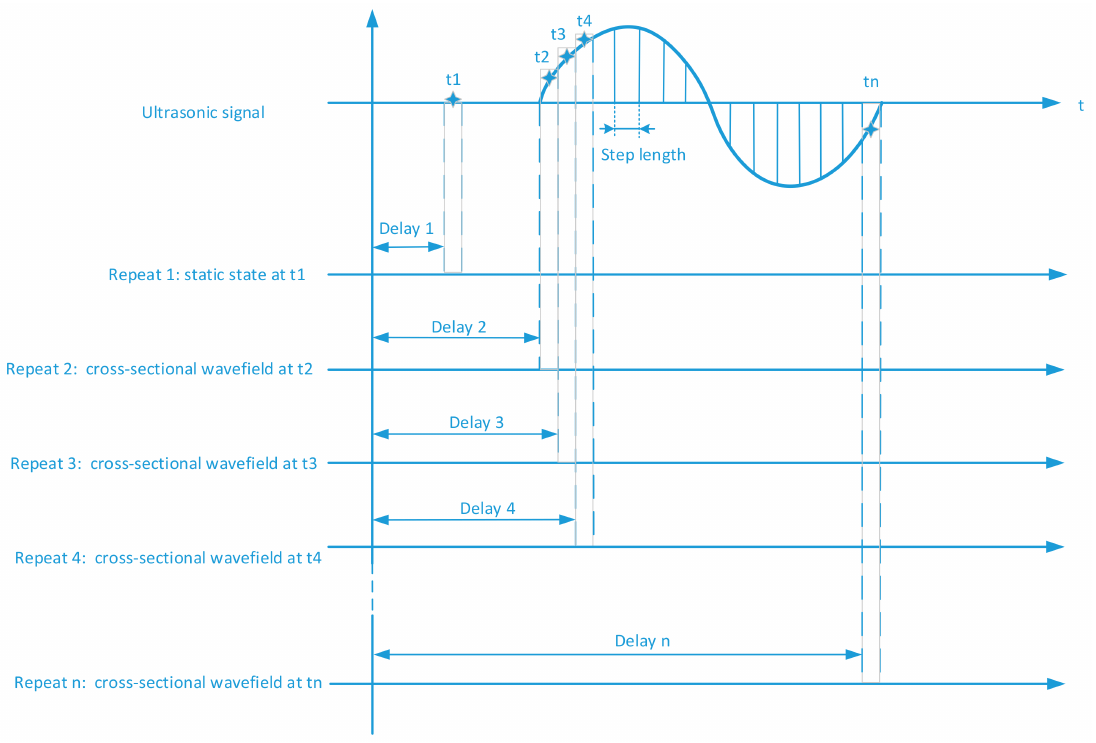
Figure 2. Acquisition of 3D ultrasonic wavefields consisting of multiple cross-sectional